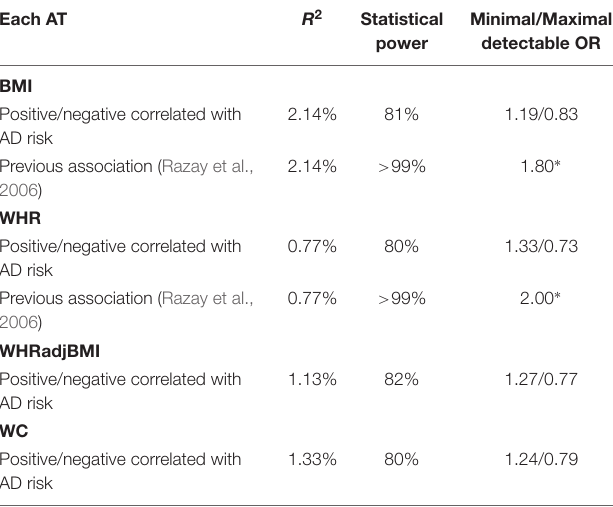
TABLE 3 | Statistical power in Mendelian randomization analyses of body shape and the risk of Alzheimer’s disease. Each